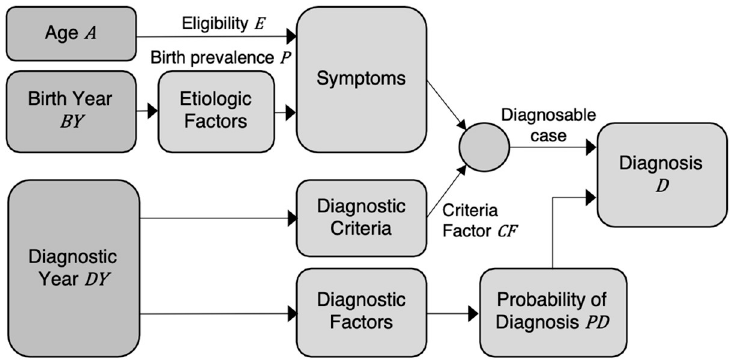
Fig 2. Directed Acyclic Graph (DAG) showing the effects of birth year, diagnostic year and age on rates of diagnoses.